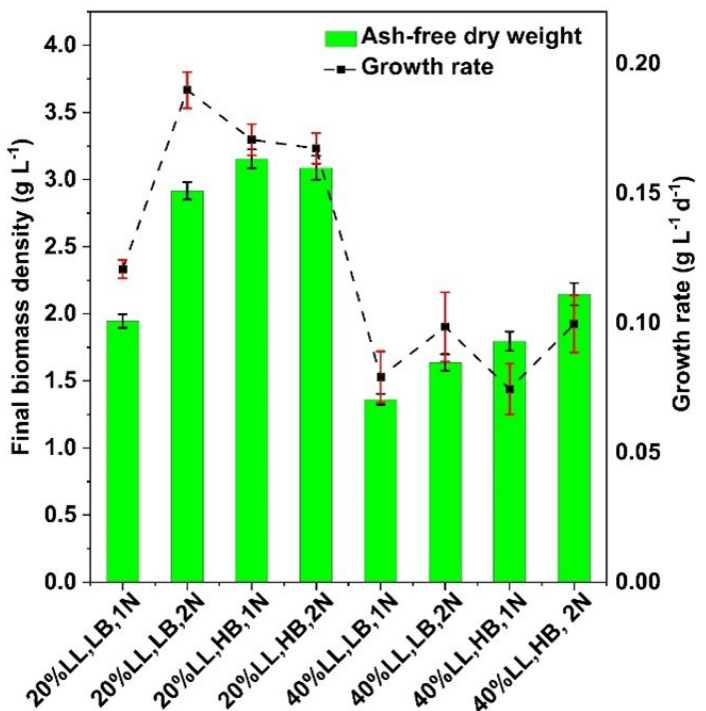
Figure 1. Final biomass density and growth rate for G. sulphuraria grown in different LL media compositions. Refer to Table 1 for LL media composition details.